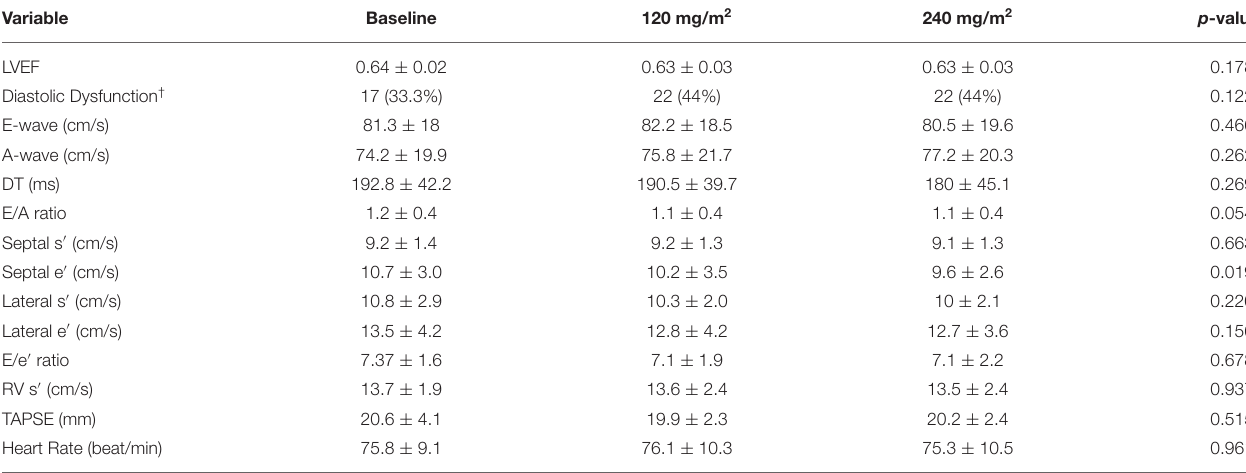
TABLE 4 | Standard echocardiographic parameters during the treatment. Variable